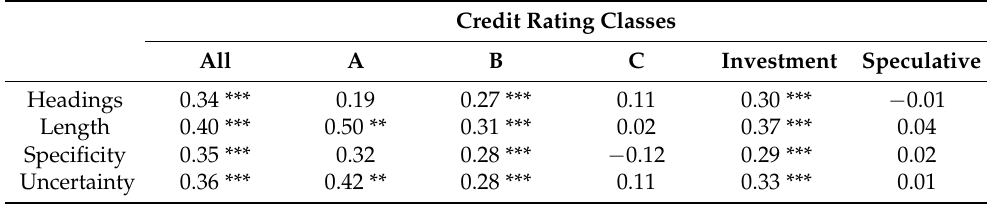
Table 3. Spearman’s rho of credit ratings and four internal textual risk measures in seven